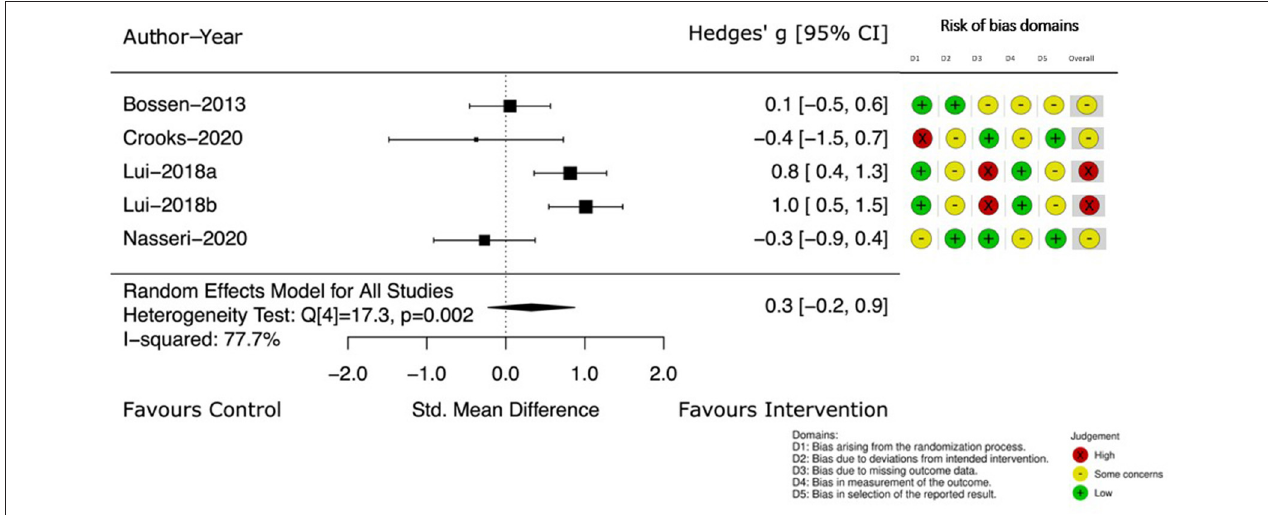
FIGURE 5 | Instrumented measurement of PA at end of